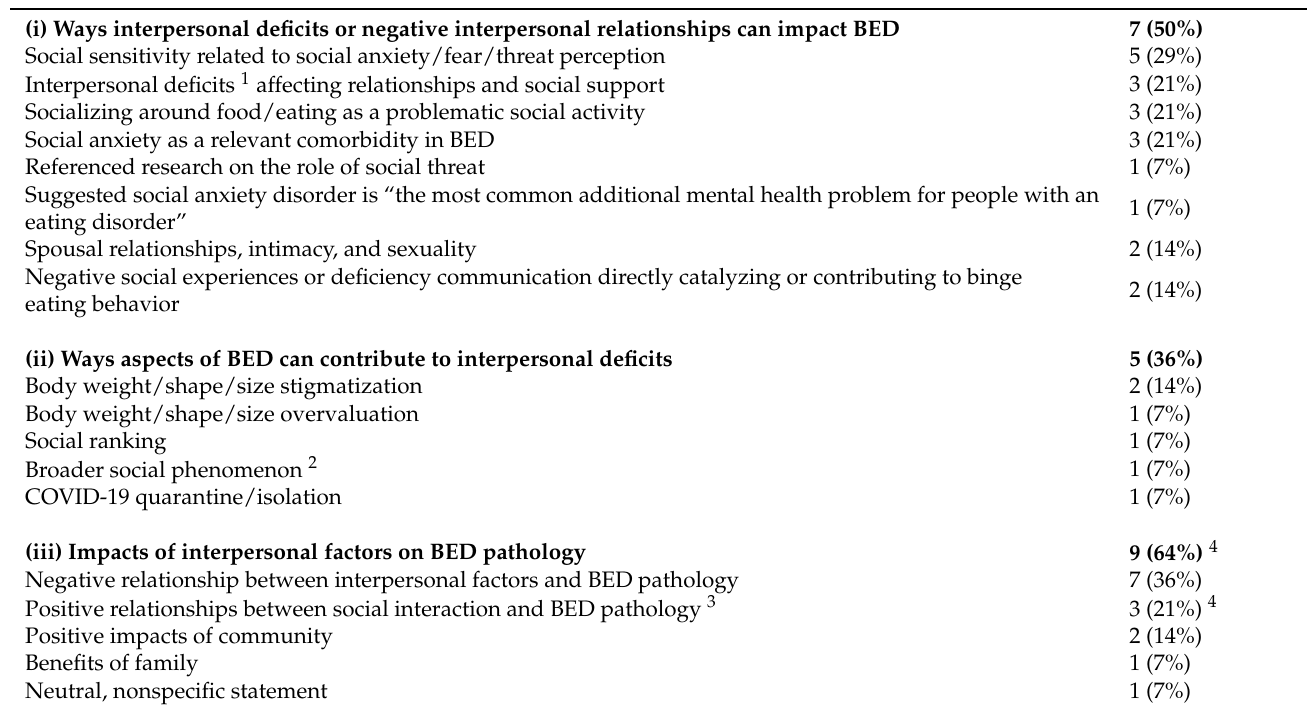
Table 9. Participant statements relating to Theme 6, “interpersonal